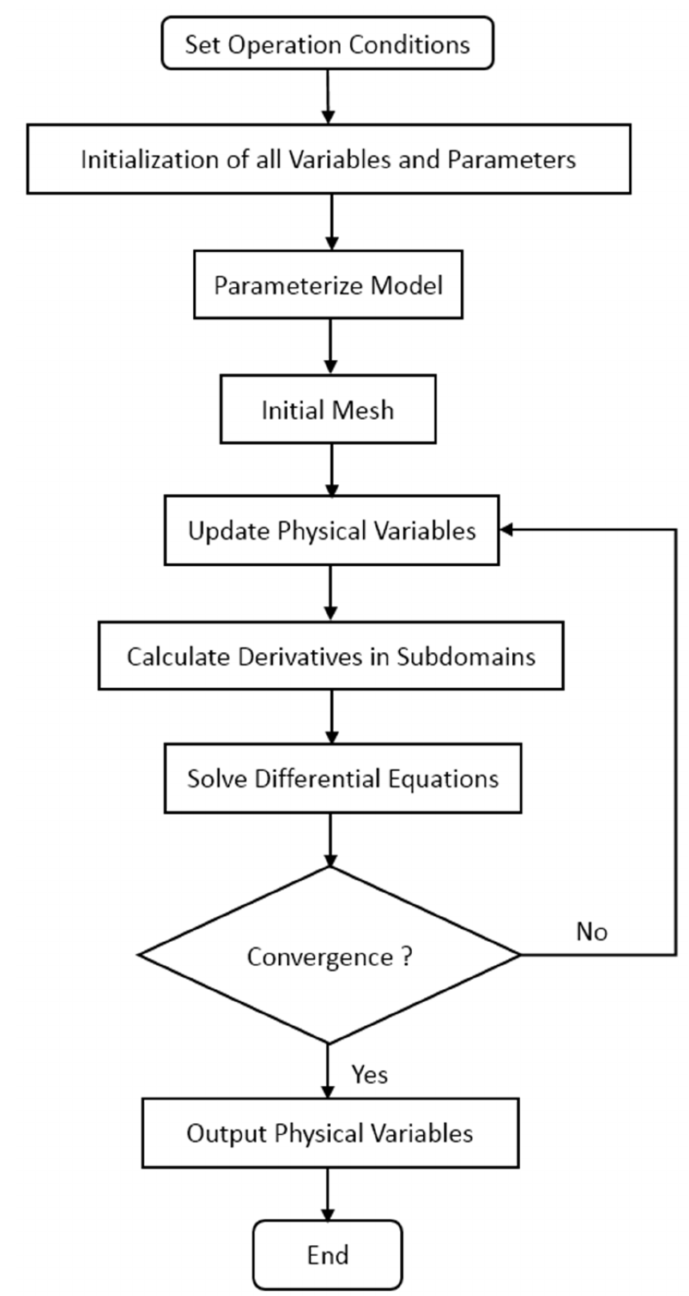
Figure 4. Illustration of the numerical solution